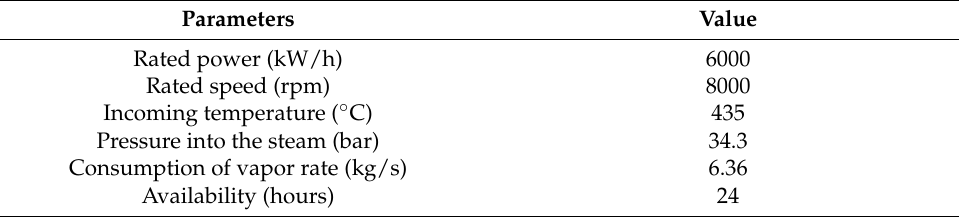
Table 2. Properties and specifications of injection steam turbine product model